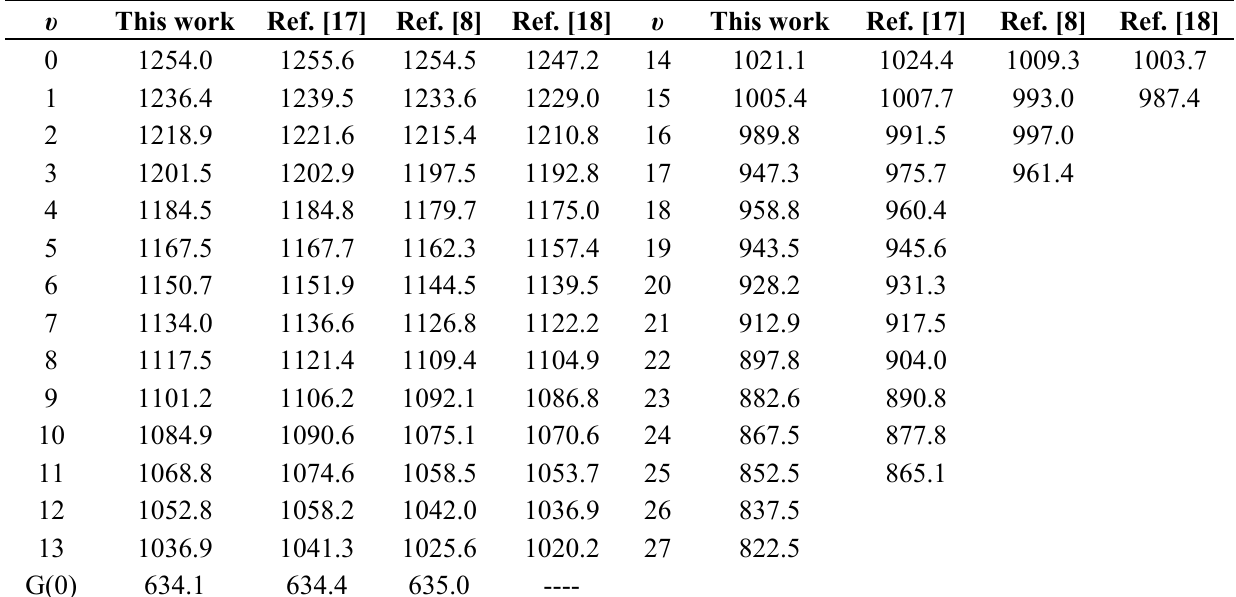
Table 2. Comparison of the present and other theoretical vibrational level spacings (in